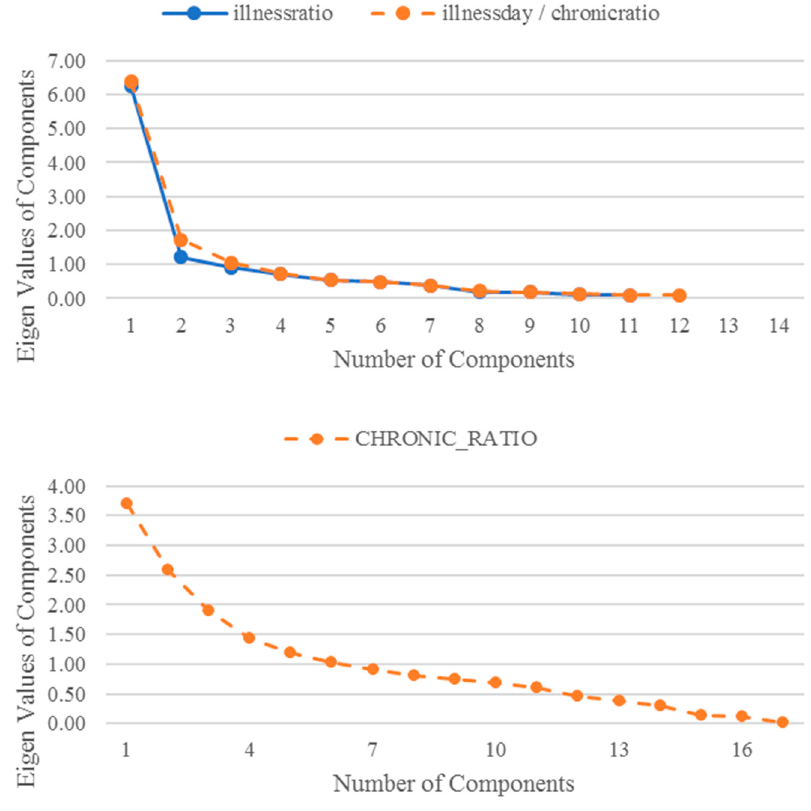
Figure A1. Scree plots. Figure B1. Scree plots. Table A3. Component loadings ( illnessratio Table B1. Component loadings ( illnessratio ).